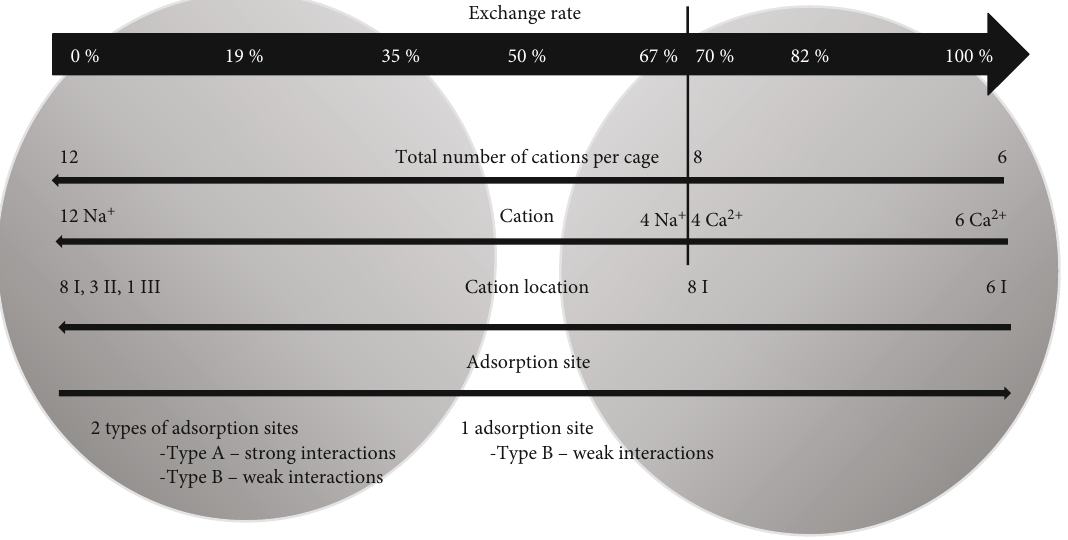
Figure 7: Changes in the α -cage during exchange of Na + cations for Ca 2+